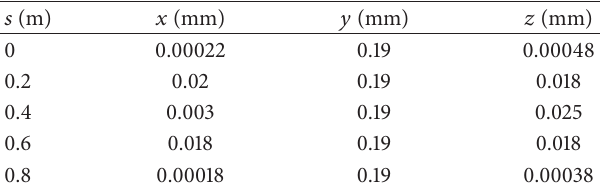
Table 6: Maximum amplitude on 35th beam element.